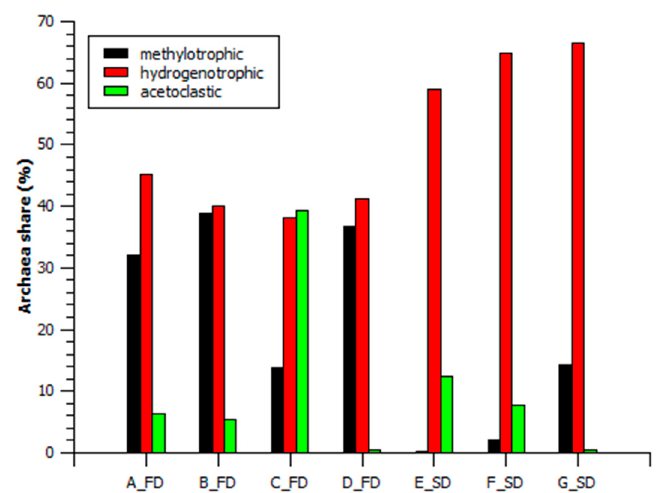
Figure 3. Metabolic share of methanogens of seven full-scale anaerobic digestion plants treating food waste and sewage sludge.